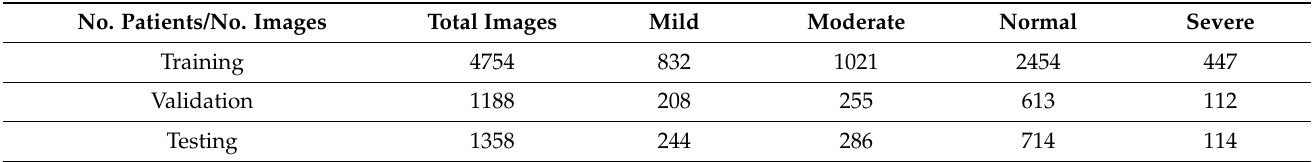
Table 3. The dataset distribution into classes.